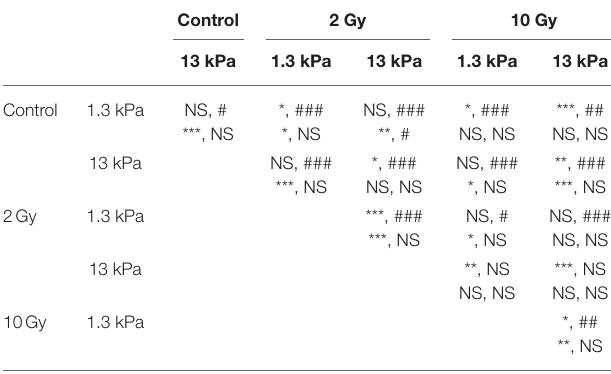
TABLE 2 | Statistical analysis for morphological